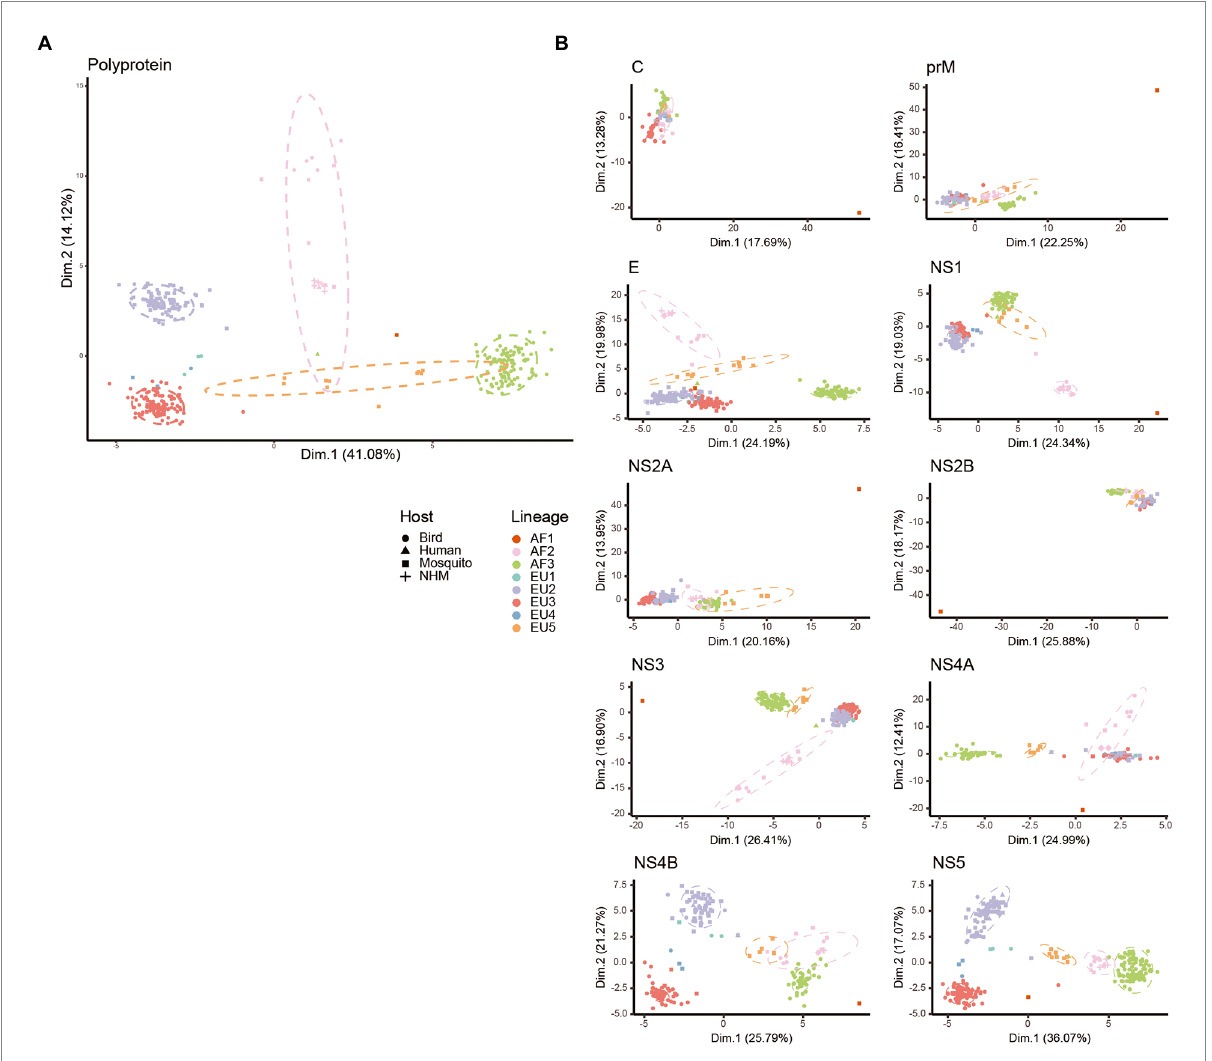
FIGURE 4 Principal component analysis (PCA) biplot diagram showing the trends of codon usage variation in USUV. PCA biplots were performed on the RSCU values of whole coding sequences (A) and every gene (B) . Every point represents a USUV strain. The point shape and color are depicted according to isolation host and lineage classification. The ellipses are drawn in a 95% confidence